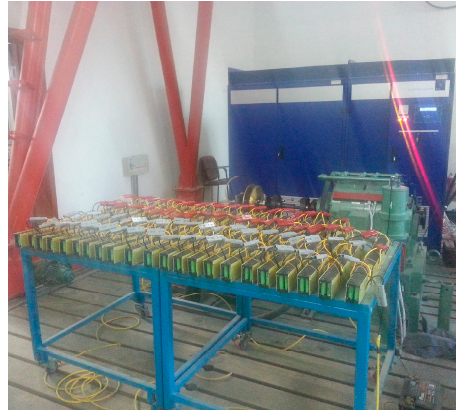
Figure 10. Battery pack and electronic load.